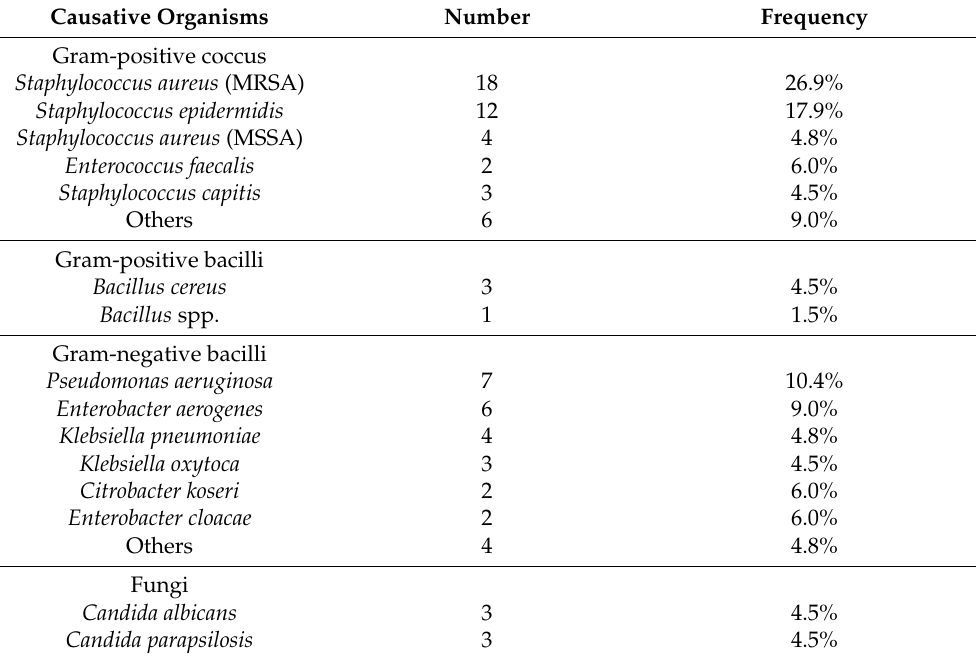
Table 4. Incidence of causative